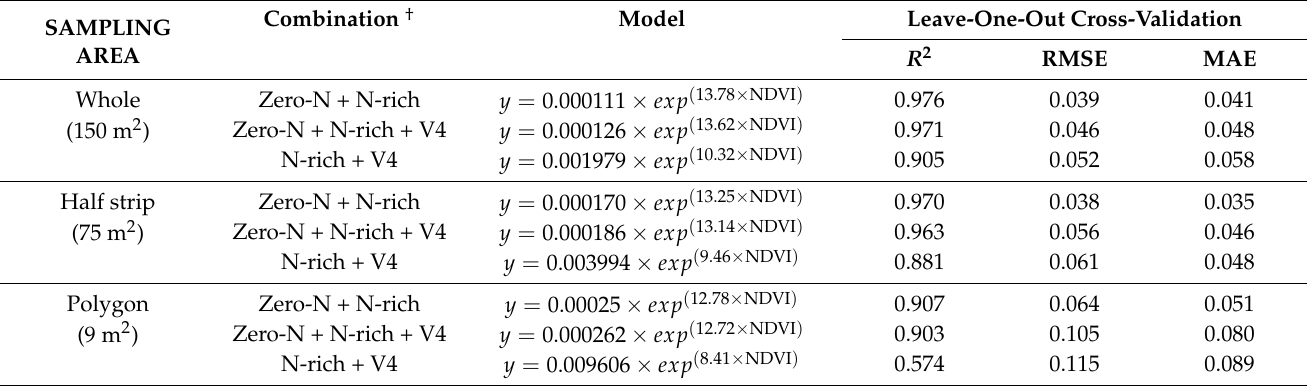
Table 1. Performance of the fitted exponential models with selected sidedress combinations at three sampling areas from the flight at R4, using leave-one-out cross-validation.